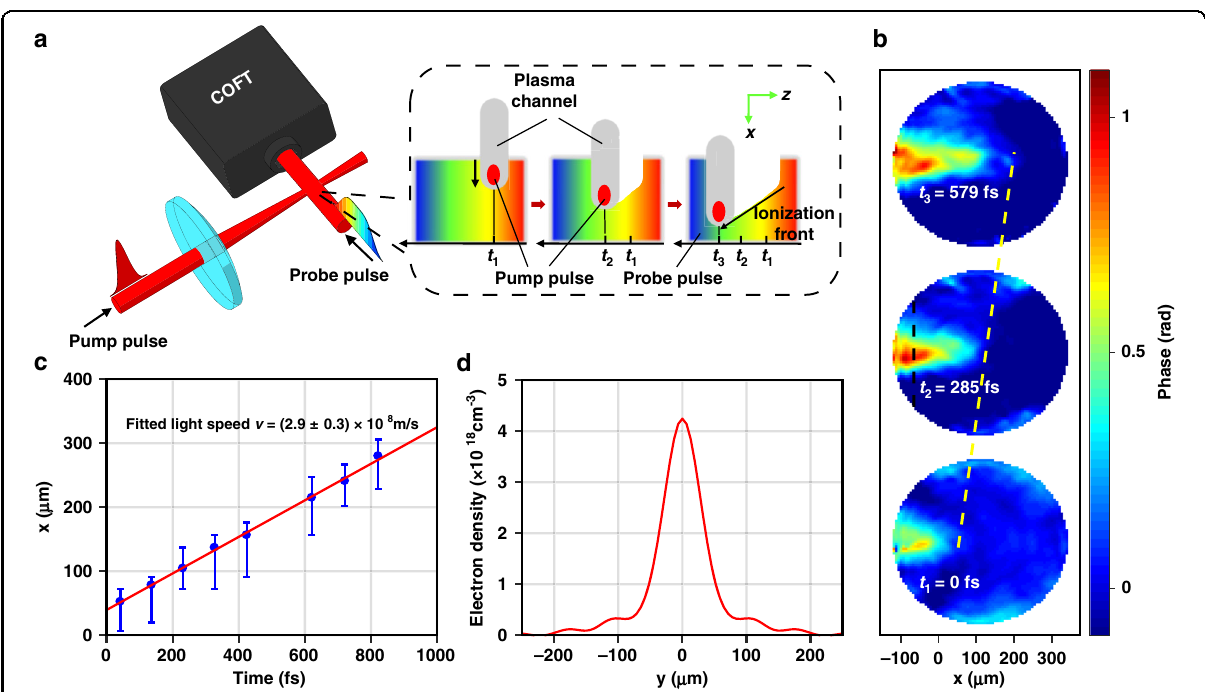
Fig. 3 Visualization of light-speed propagation of an air plasma ionization front by COFT measurement of the probe pulse. a Schematic diagram of the pump-probe experiment visualizing the light-speed propagation of the air plasma ionization front in air. The pump pulse (1 mJ, 40 fs) propagating along the x-direction is focused and ionizes the air. The probe pulse detects the pump-induced refractive index shift transversely and enters a COFT system based on wavefront retrieval and non-collinear FROG, with the interacting region as CP. The inset cartoon shows the process of the probe picking up the pump-induced phase shift. At time t 1 , the pump and the plasma channel overlap with the leading edge of the probe; at time t 2 , with the probe central part; at time t 3 , with the trailing edge. b Representative frames of the probe pulse transverse phase shift pro fi les in the x - y plane at t ¼ 0 ; 285 ; 579 fs. The yellow dashed line shows the position of the ionization front at different time. c Linear fi tting of the ionization front positions at different time, and the slope is consistent with light speed. d Free electron density pro fi le along the black dashed line in b , reconstructed via a standard Abel inversion